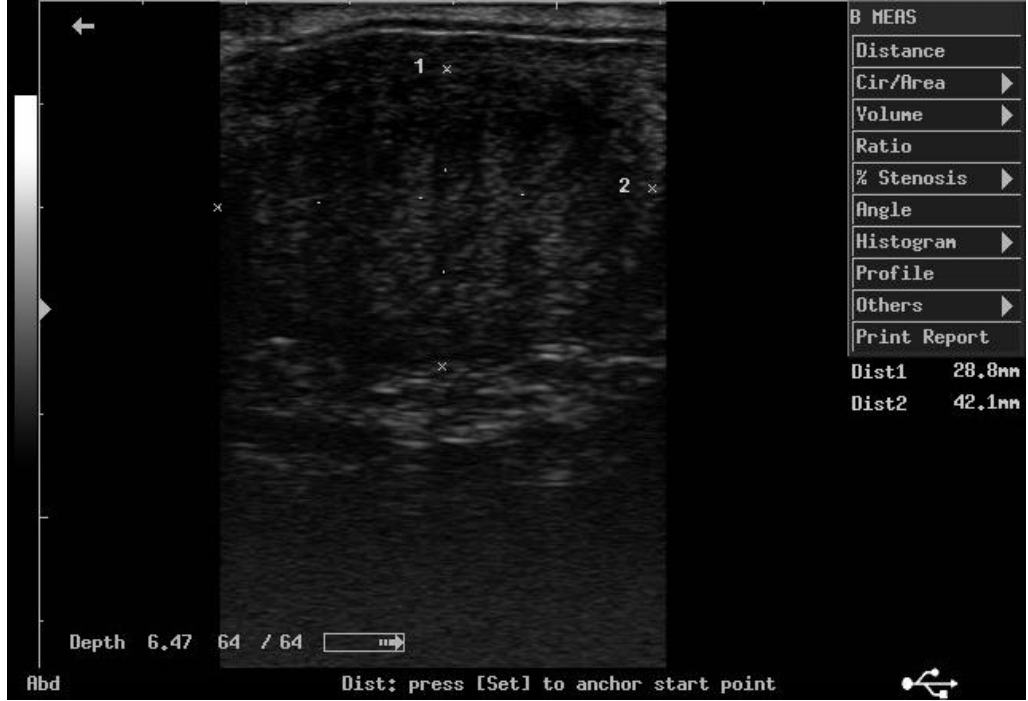
Figure 1. Ultrasound image of the middle tract of the post-pregnant uterine horn, at day 7 postpartum.